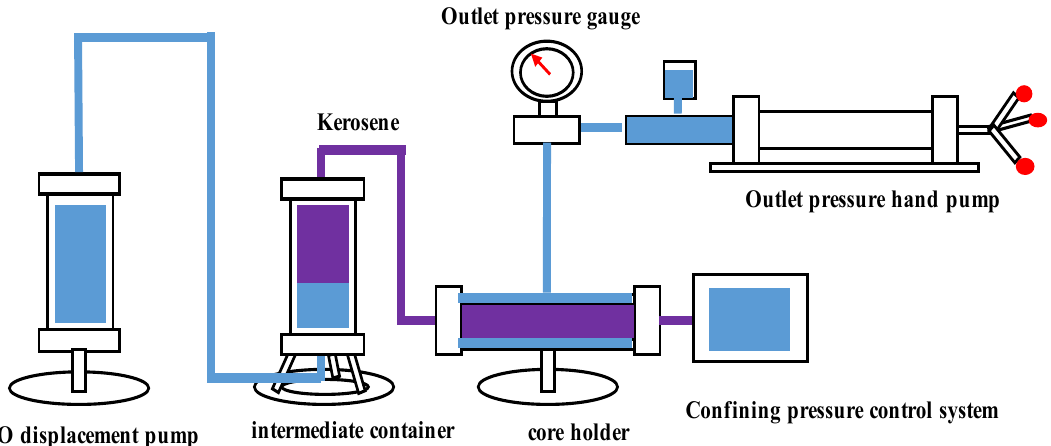
Figure 1. Experimental connection equipment.